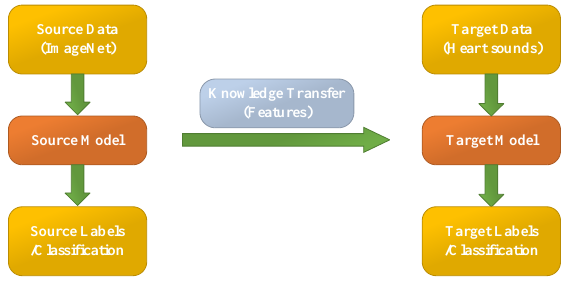
Figure 5. The process of transfer learning.